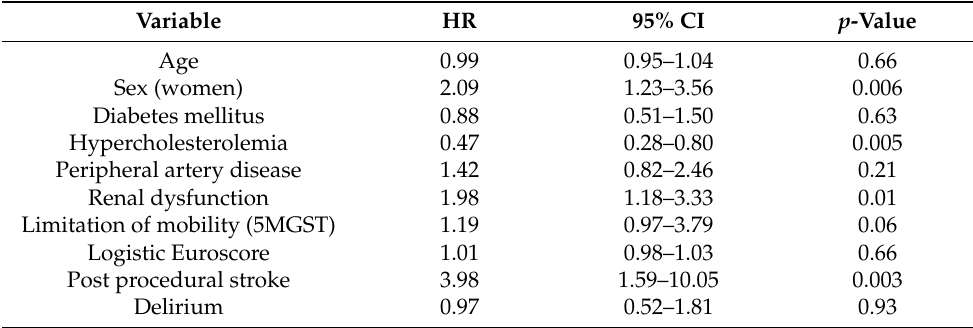
Table 4. Multivariable Cox analysis for 3-year mortality in the MPI-2–3